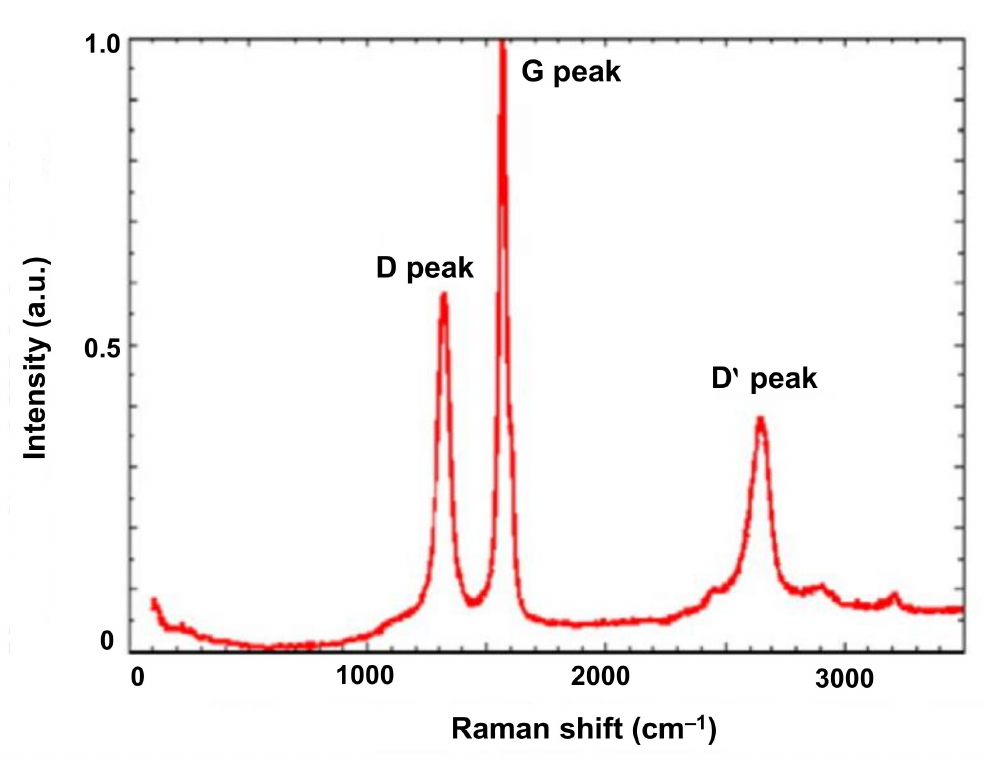
Figure 8. An illustration of Raman spectra of CDs. Reproduced from [181], with permission from Elsevier, 2013. a.u.: arbitrary